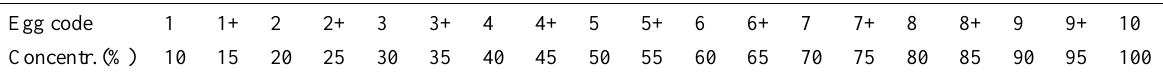
Table 2. Conversion from the CIS egg-code total concentration ( C t , given in tenths) into ice concentration shown in this paper. The egg-code labels OW (open water) and IF (ice-free) are converted to 0% and FAST (fast ice) to 100%. Egg code